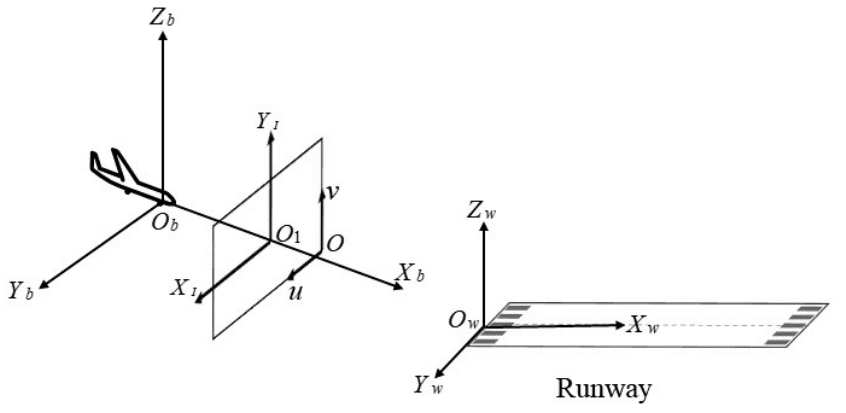
Figure 7. Illustration of reference coordinate